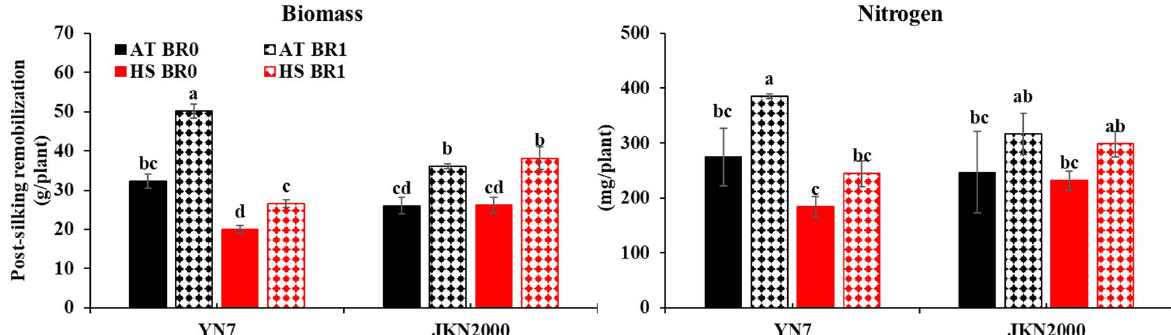
Figure 3. Effects of foliar BR application at the silking stage on post-silking remobilization of biomass and nitrogen of fresh waxy maize under post-silking ambient and high temperatures. AT, ambient temperature; HS, heat stress; BR0, application of water; BR1, application of 0.25 mg/L BR. The different letters on the column mean the difference was significant at the p < 0.05